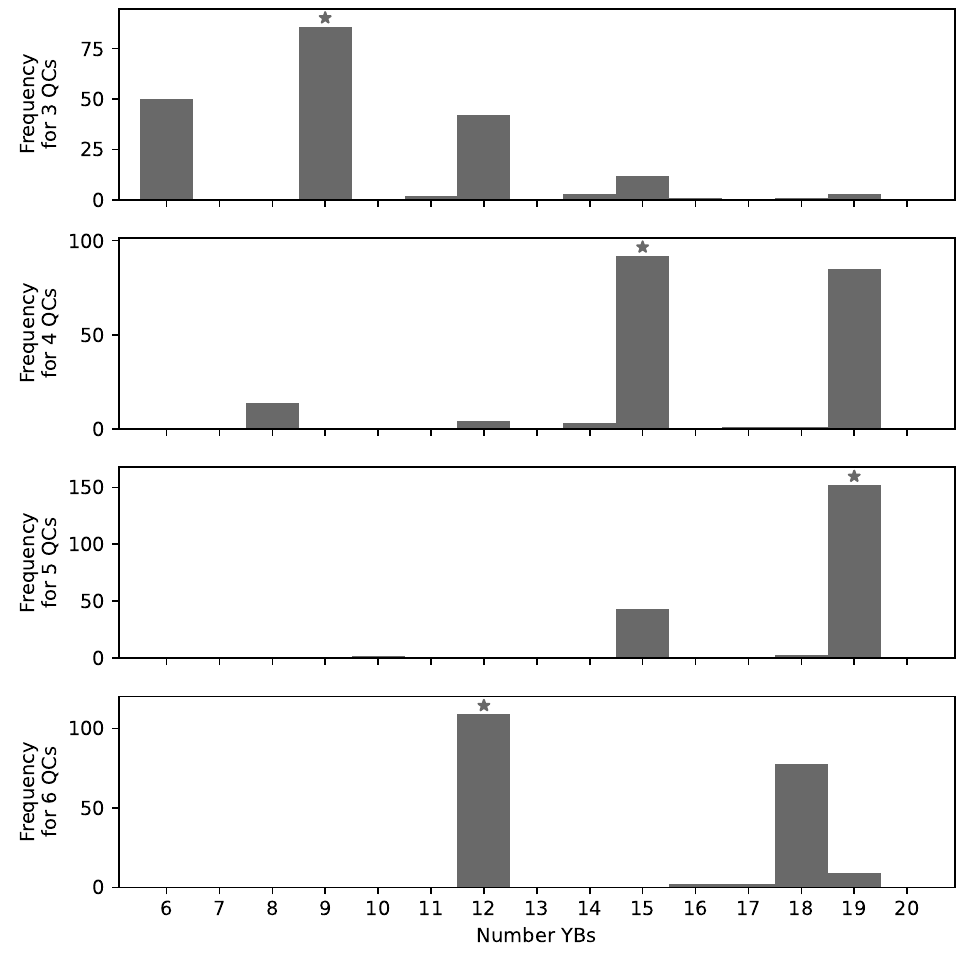
Figure 9. The number of YBs in the set of approximated optima. The parameter value that leads to the best objective function value over all optimization runs is marked with an asterisk.